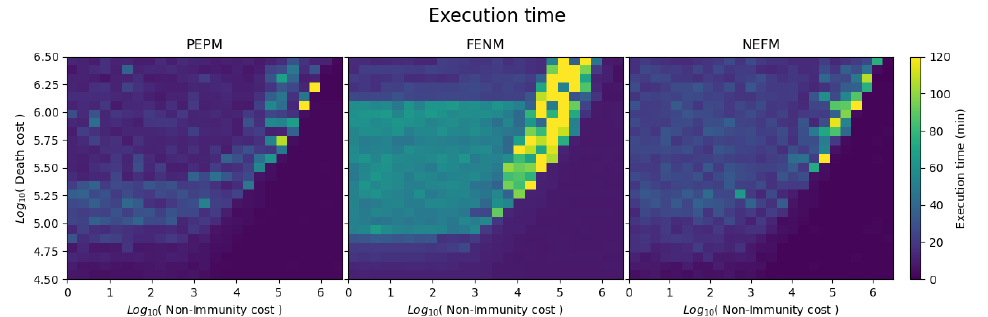
Figure 12. Runtimes of PEPM, FENM, and NEFM algorithms as a function of death and non- immunity non-immunity costs.